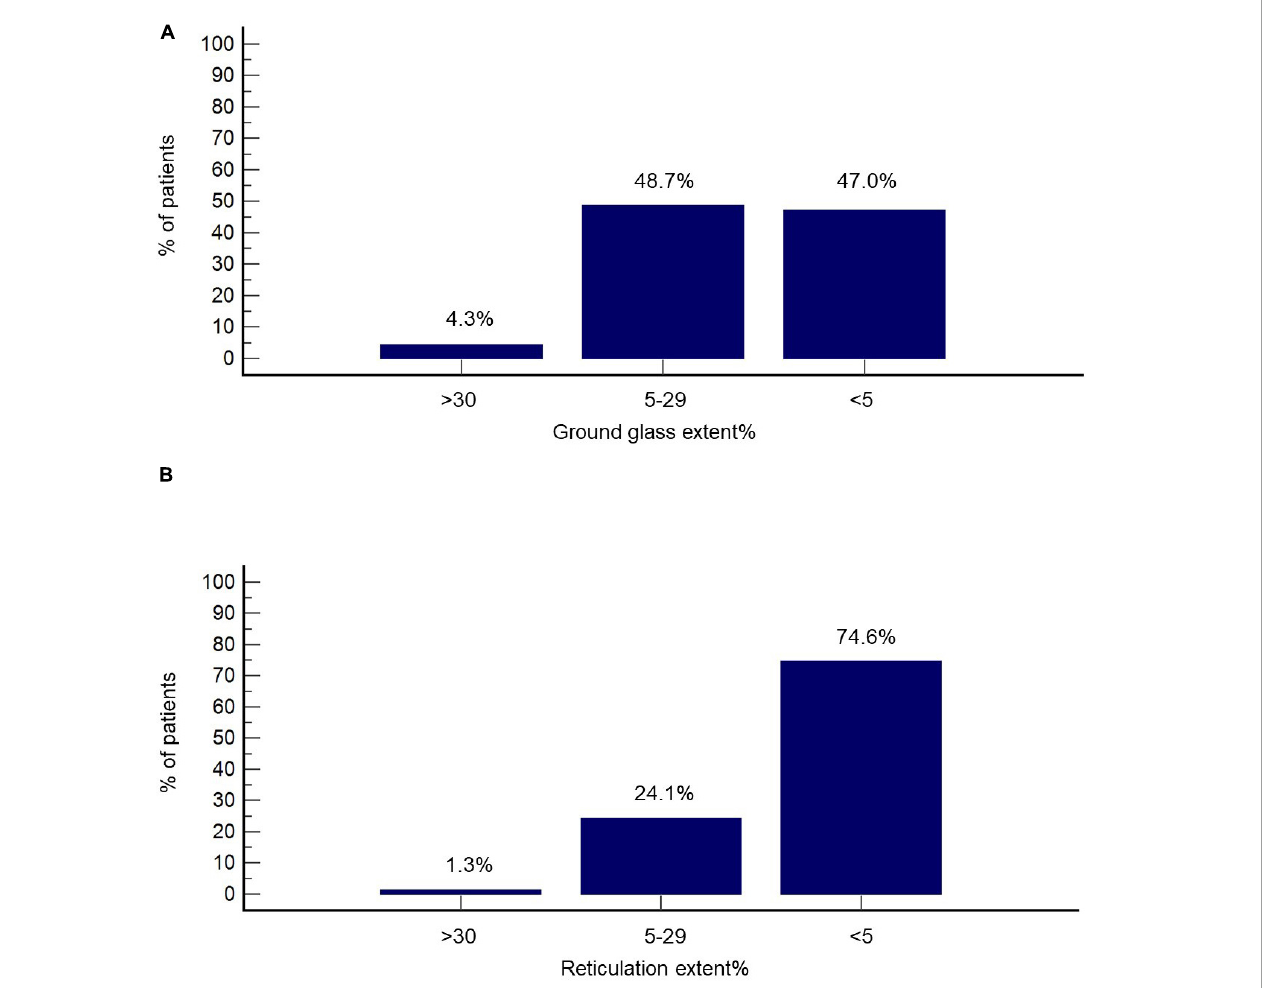
FIGURE2 Radiographic features at the 3-month follow-up based on Imbio Lung Texture Analysis 2.1. Percentage of patients with% extent ground glass (A) and % extent reticulation (B) above 30, between 5 and 29, as well as below 5 is